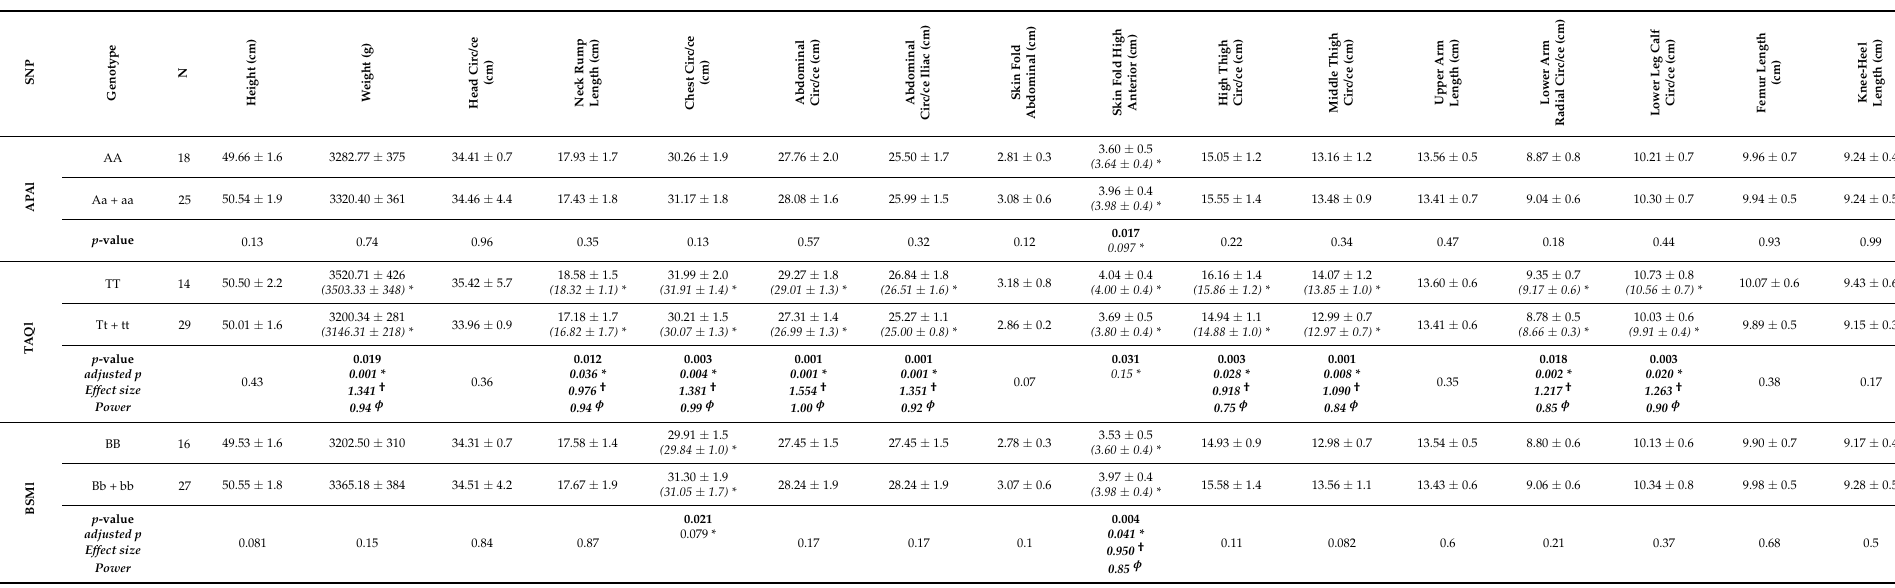
Table 6. Birth neonatal anthropometry (maternal vitamin D status at birth <50 nmol/L) according to maternal VDR